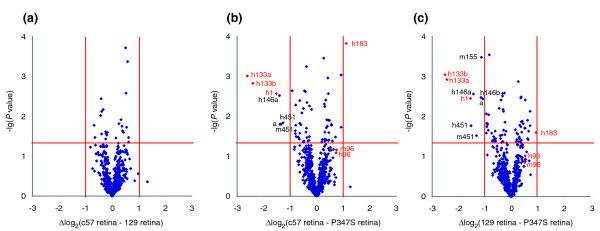
Volcano plots of miR expression in P347S and wild-type retinas. Plots represent comparative microRNA (miR) expression profiles of (a) c57 versus 129 retinas, (b) c57 versus P347S (mutant pro347ser RHO transgene) retinas, and (c) 129 versus P347S retinas using Ambion miR microarrays. X-axis indicate difference of expression level on a log2 scale, while y-axis represents corresponding P values (Student's t-test) on a negative log scale; more lateral and higher points mean more extensive and statistically significant differences, respectively. Red lines indicate differences of ± 1 and significance level of P = 0.05. Labels are given for miRs with changes of higher than ± 1 (P < 0.05). MiR-1, miR-96, miR-133, and miR-183 are highlighted in red; h and m in labels refer to human and mouse miRs.